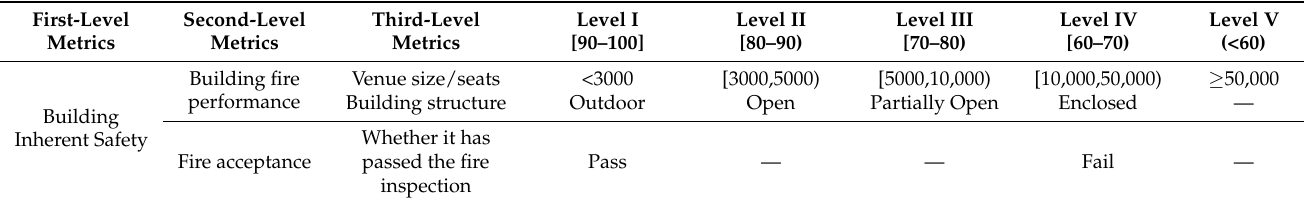
Table 2. Examples of static fire risk indicators for